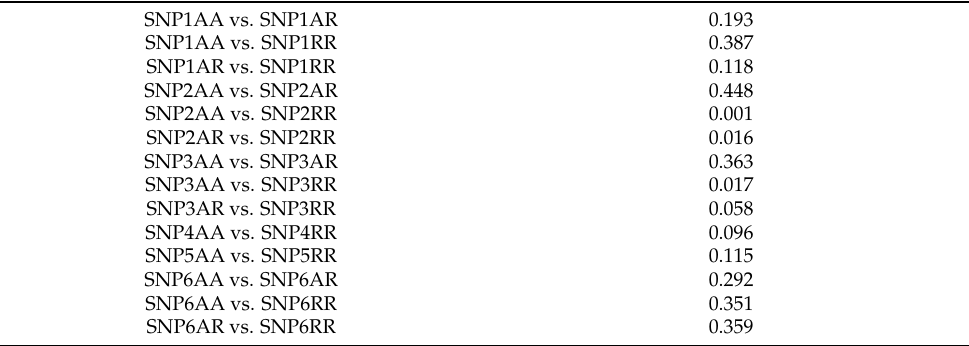
Table 3. p -Values for comparison of SNP groups by reached fitness u (2) with Mann–Whitney– Wilcoxon